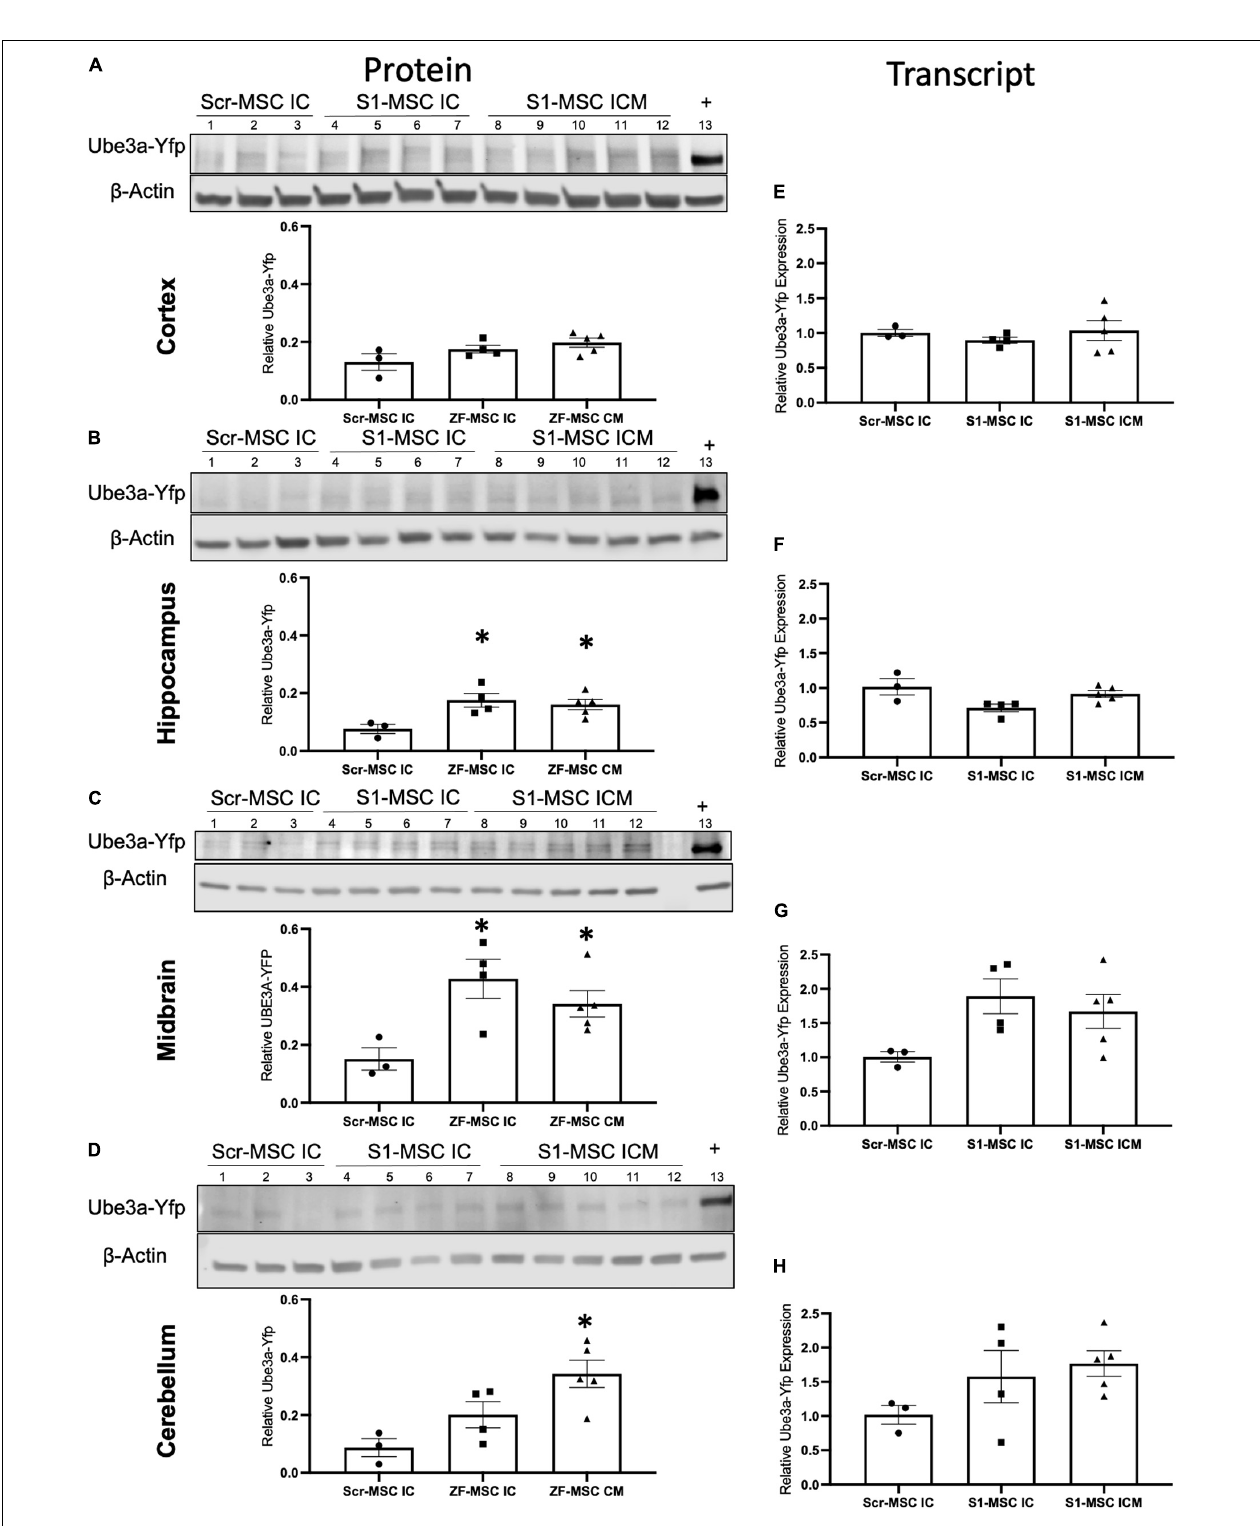
FIGURE 5 | ZF-MSC demonstrate route of administration-dependent activation of Ube3a Yfp 3 weeks following injection. (A–D) Representative Western blots of neuronal subregions with corresponding quantitative graphs. Graphical values normalized to a maternal Ube3a Yfp positive control. Individual dots represent a single mouse. n = 3–5 mice per group. Lanes 1–3 = Scr-MSC IC. Lanes 4–7 = ZF-MSC IC. Lanes 8–12 = ZF-MSC ICM. Lane 13 = Positive YFP control. (A) No significant changes in cortical UBE3A-YFP protein expression were found following either ZF-MSC IC or ZF-MSC CM treatment. One-Way ANOVA [ F ( 2 , 9 ) = 3.103] followed